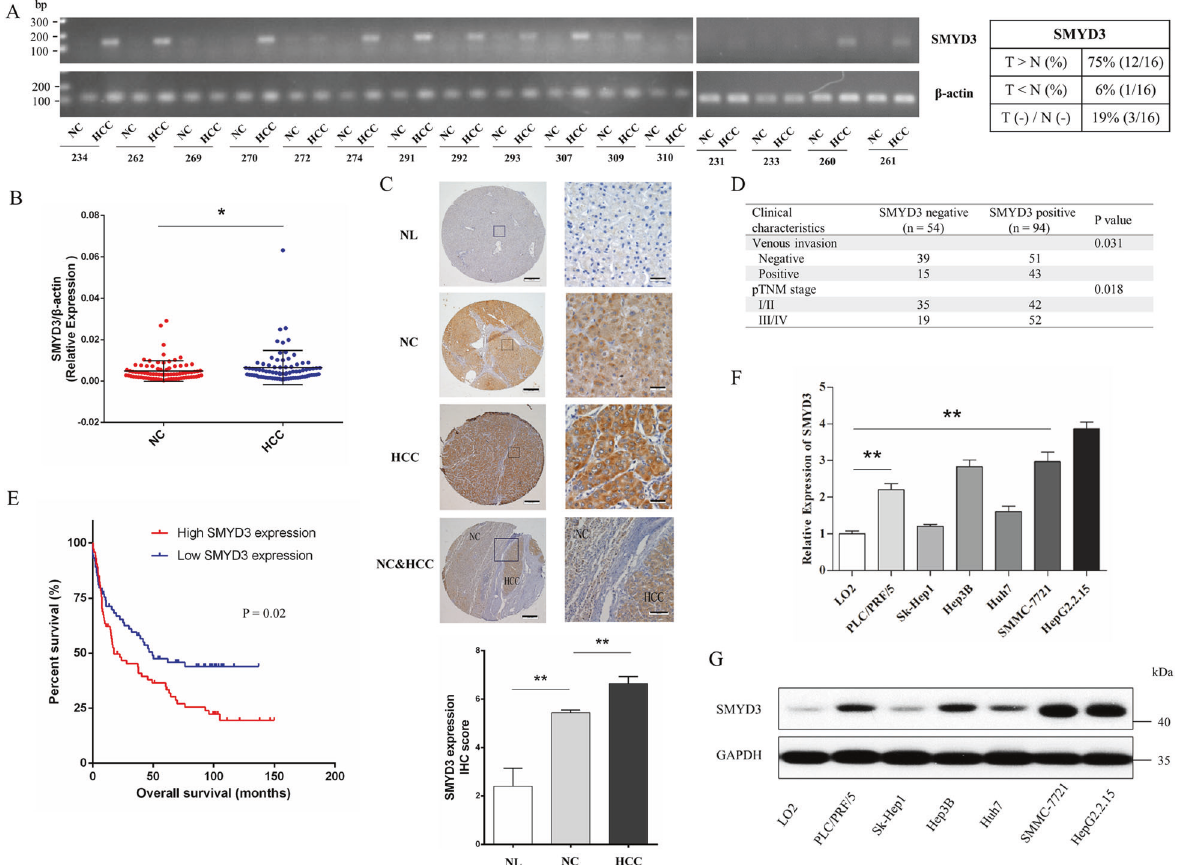
Fig. 1 SMYD3 was overexpressed and associated with aggressive behaviors in hepatocellular carcinoma (HCC) tissues. A Reverse transcription-polymerase chain reaction (RT-PCR) analysis of SMYD3 mRNA expression levels in paired HCC and adjacent noncancerous tissues from 16 patients. B Quantitative real-time polymerase chain reaction (qRT-PCR) analysis of SMYD3 mRNA expression levels in 80 paired HCC and adjacent noncancerous tissue samples. C Immunohistochemistry (IHC) analysis of SMYD3 expression in 10 normal liver samples and 148 pairs of HCC and adjacent noncancerous tissue samples. D Correlations between SMYD3 expression and the clinicopathological characteristics of patients with HCC were determined using the chi-square test. SMYD3-negative was de fi ned as an IHC score ≤ 4; SMYD3-positive was de fi ned as an IHC score >4. E Kaplan-Meier analysis of overall survival in 148 patients with HCC strati fi ed by SMYD3 expression. The median expression level was used as the cut-off. Low SMYD3 expression in each of the 148 patients was de fi ned as a value below the 50th percentile. High SMYD3 expression in each of the 148 patients was de fi ned as a value above the 50th percentile. F , G Expression of the SMYD3 mRNA and protein in different HCC cell lines. Bar = 200 μ m. Data are presented as the means ± SD of three separate experiments, each performed in triplicate. * P < 0.05; ** P <